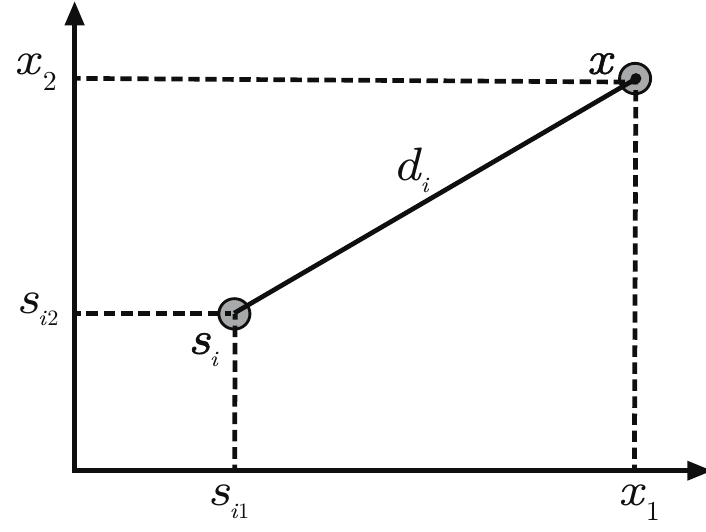
Figure 1. Schematic diagram of anchor and target position.